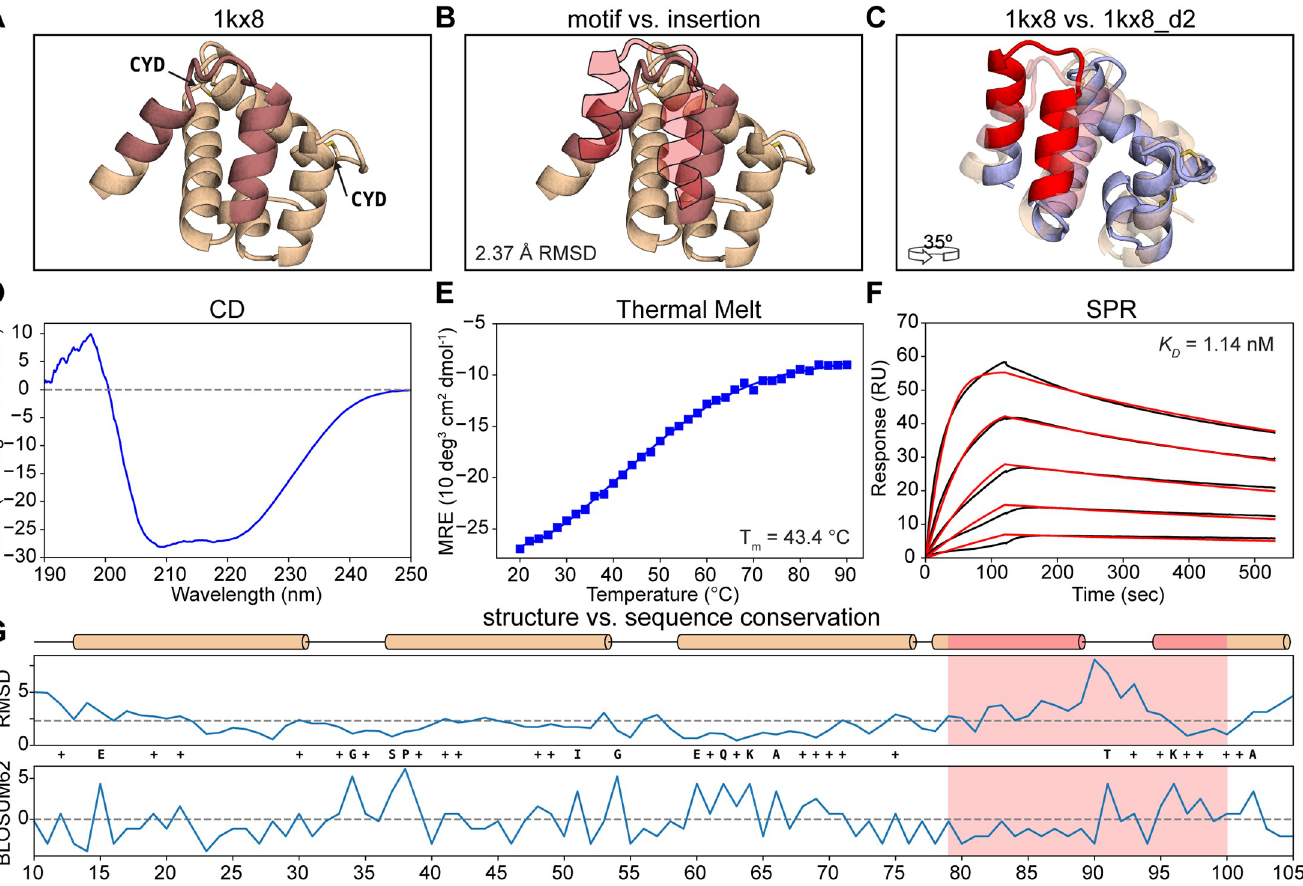
Fig 5. Functional design of a distant structural template. A) Structural representation of 1kx8. The insertion region is colored in light red and the two disulfide bonds are labeled (CYD). B) Structural comparison between the insertion region of 1kx8 and the site II epitope (light red-filled silhouette). The local RMSD between the two segments is 2.37 Å . C) Superposition between 1kx8_d2 design model (blue with red motif) and the 1kx8 template (wheat and light red insertion site). Multiple conformational shifts are required throughout the structure to accommodate the site II epitope. D) CD spectrum of 1kx8_d2 showing a typical alpha-helical pattern with the ellipticity minima at 208 nm and 220 nm. E) 1kx8_d2 shows a melting temperature (T m ) of 43.4˚C. F) Binding affinity determined by SPR. 1kx8_d2 shows a K D of 1.14 nM. Experimental sensorgrams are shown in black and the fitted curves in red. G) Per-position evaluation of structural (top) and sequence (bottom) divergence between the design model 1kx8_d2 and the starting template 1kx8. The largest structural differences are observed in the epitope insertion region, the overall difference of the two structures is 2.25 Å (dashed line). The sequence was evaluated using the BLOSUM62 score matrix, yielding a total of 13.5% identity and 38.5% similarity. The epitope region is colored in light red. Identical positions between the 1kx8_d2 and 1kx8 are labeled with the residue one letter code, while positively scored changes are labeled with plus